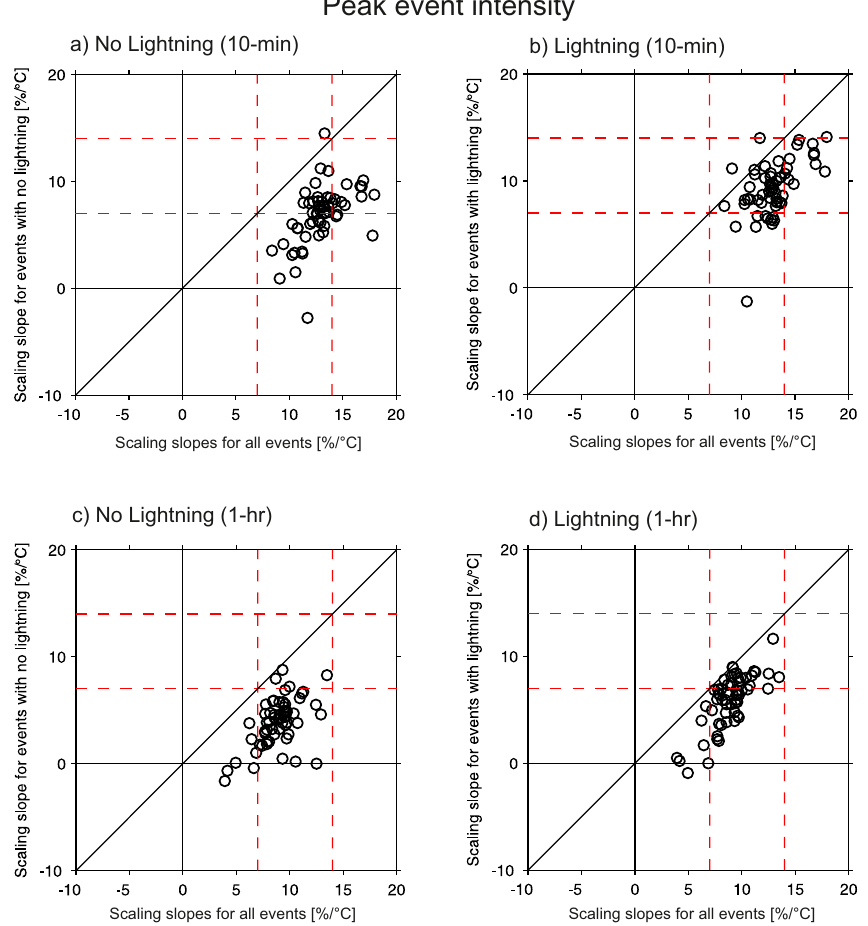
Figure 5. Scatter plots of station-derived estimates of scaling slopes for peak event intensity I p in lightning and no-lightning events versus all events at the (a–b) 10min and (c–d) 1h resolutions using the quantile regression method (95th percentile). Red dashed lines indicate the CC rate (7% ◦ C − 1 ) and 2CC rate (14% ◦ C − 1 ). The same figure for the temperature binning method is in the